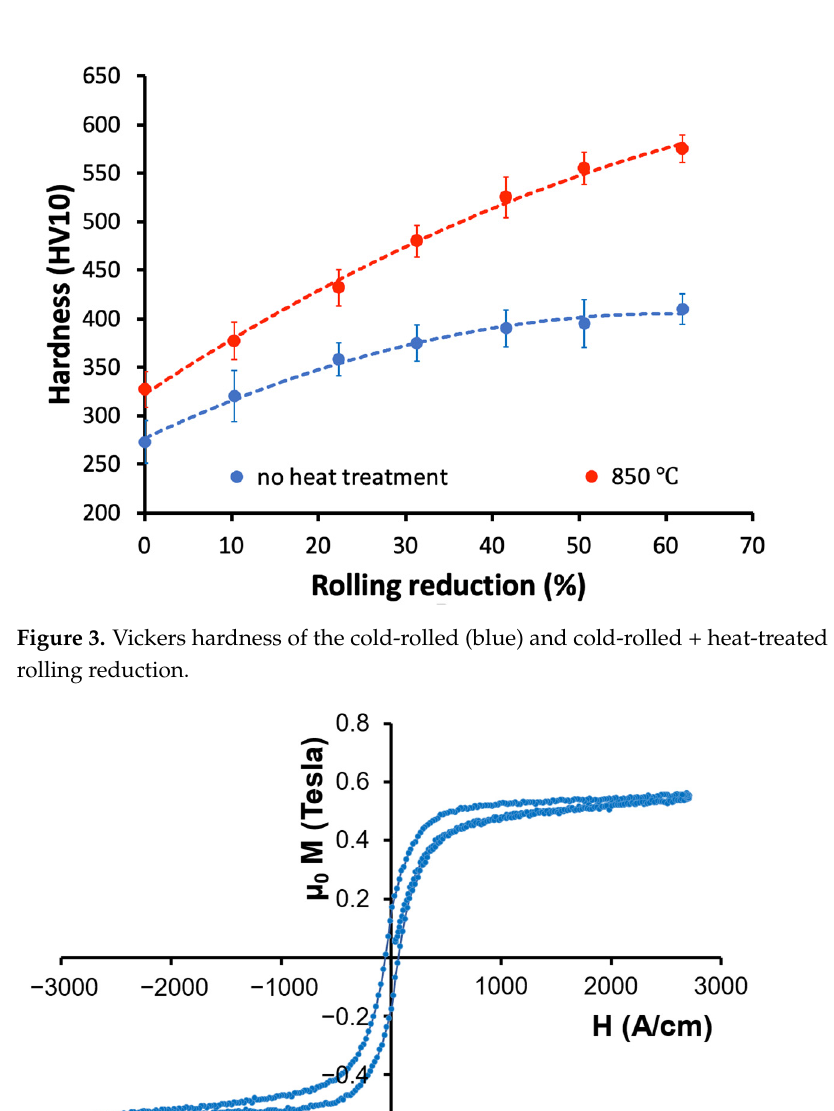
( d ) Figure 2. Optical microscopic images of tested DSS specimens after heat treatment at 850 °C for 30 min. ( a ) No deformation; ( b ) 22.3% rolling reduction; ( c ) 41.6% rolling reduction; ( d ) 6.9% rolling reduction. The Vickers hardness increased with a square root function trend for untreated sam- ples (Figure 3) due to cold rolling. The following function can be fitted to the measured points of the deformed but not heat-treated sample ∆HV10 = 17.56√𝜀 (R 2 = 0.994). Where: